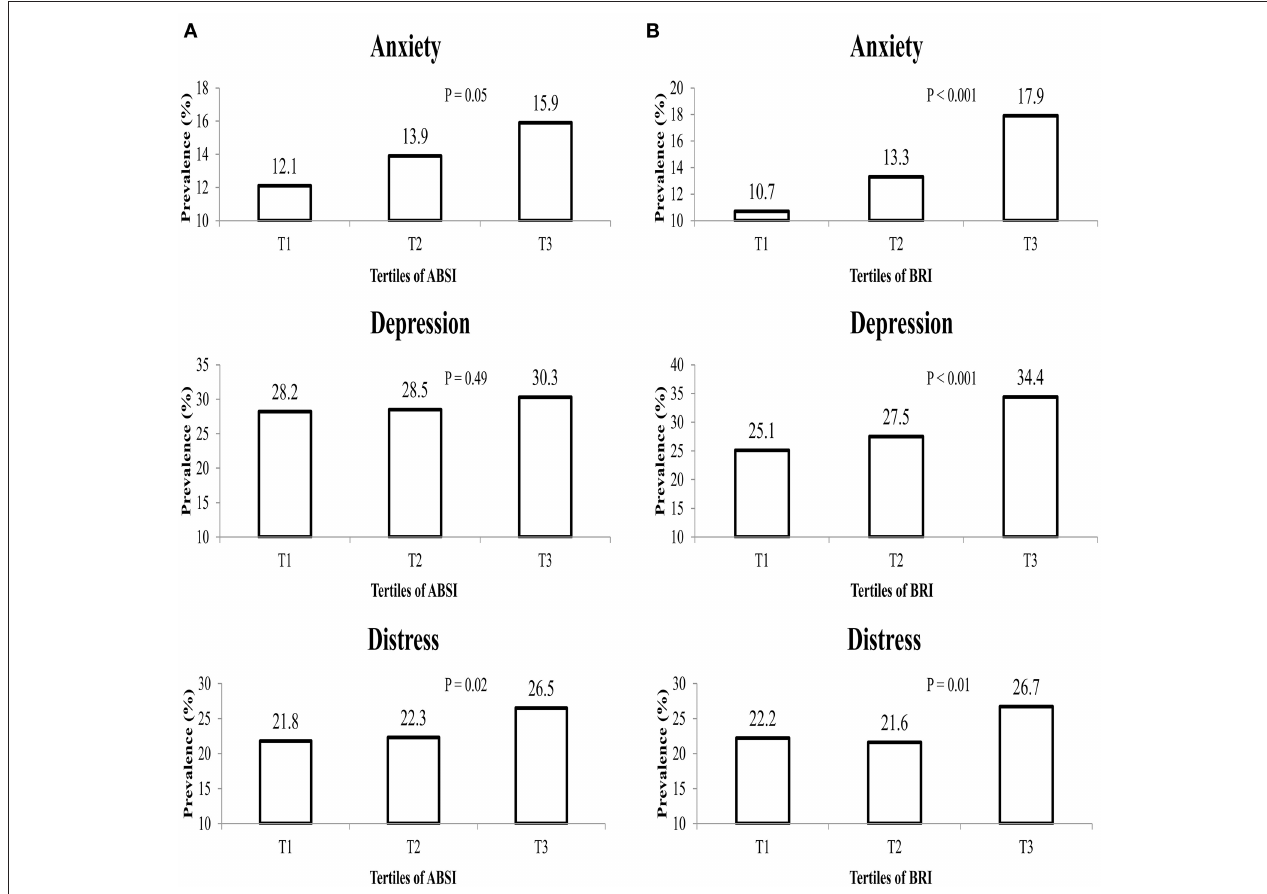
FIGURE 1 | The prevalence of anxiety, depression and distress in study participants across tertiles of (A) ABSI, and (B) BRI.